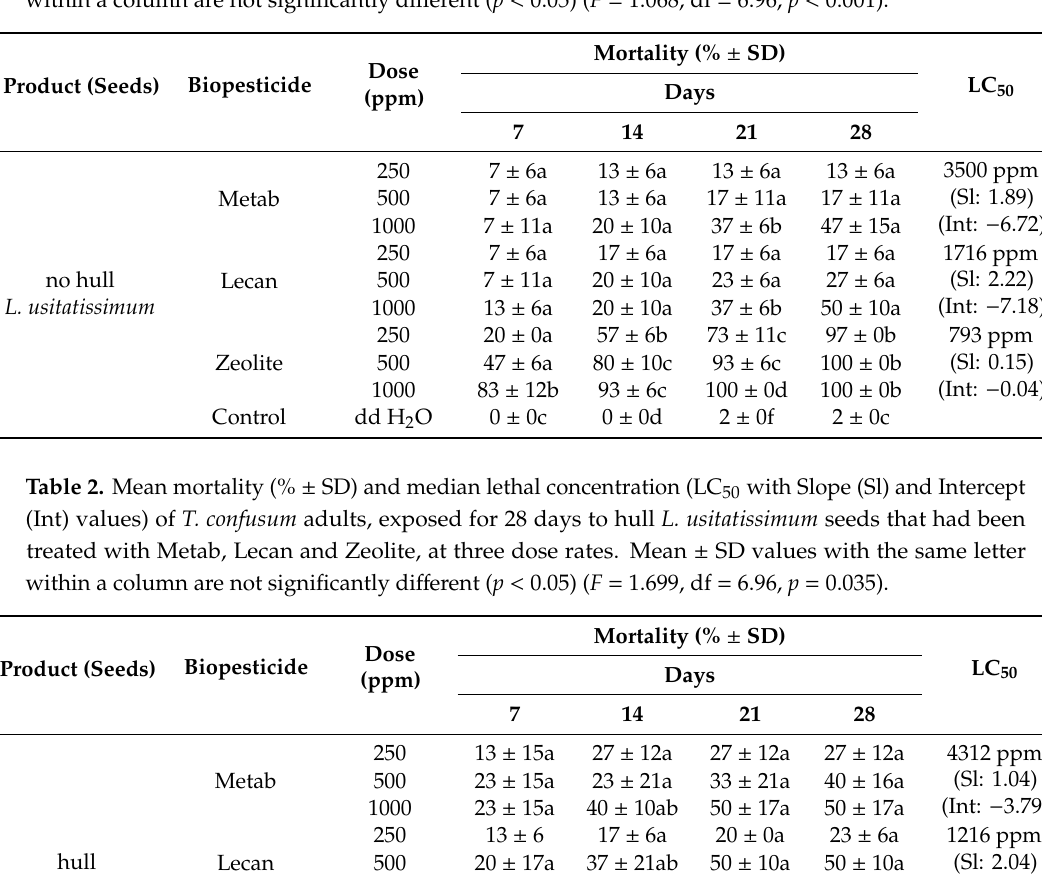
Table 1. Mean mortality (% ± SD) and median lethal concentration (LC 50 with Slope (Sl) and Intercept (Int) values) of T. confusum adults, exposed for 28 days to no hull L. usitatissimum seeds that had been treated with Metab, Lecan and Zeolite, at three dose rates. Mean ± SD values with the same letter within a column are not significantly di ff erent ( p < 0.05) ( F = 1.068, df = 6.96, p < 0.001).